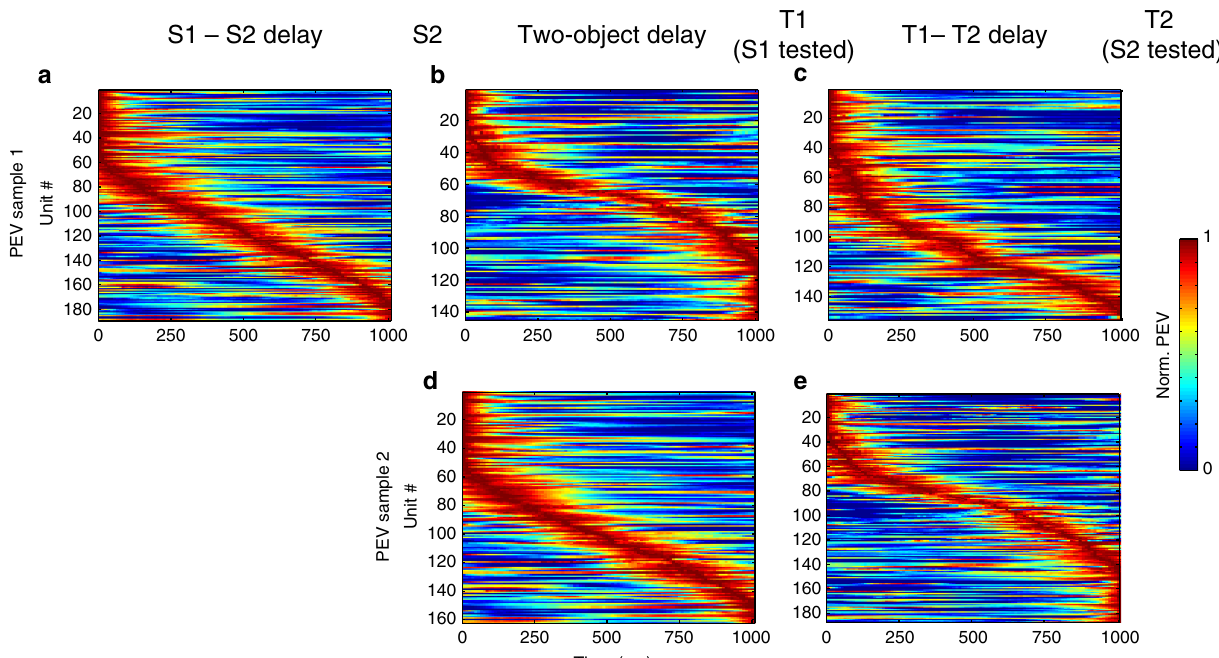
Fig. 5 PEV information during different types of delays. The data from trials with matching test sequences. Plotted is the normalized PEV information about sample 1 (S1; top panels: a - c ) or sample 2 (S2; bottom panels: d , e ) during S1 – S2 delay (left column), two-object delay (middle column) and T1 – T2 delay (right column) for all units with signi fi cant PEV ( p < 0.01; ANOVA, tested in each delay and for each sample independently). Units are sorted based on the timing of peak PEV in each delay. Following two-object delay, S1 is tested. Following T1 – T2 delay, S2 is tested. Included in each plot are all neurons that had signi fi cant PEV in that particular delay ( n = 144 –